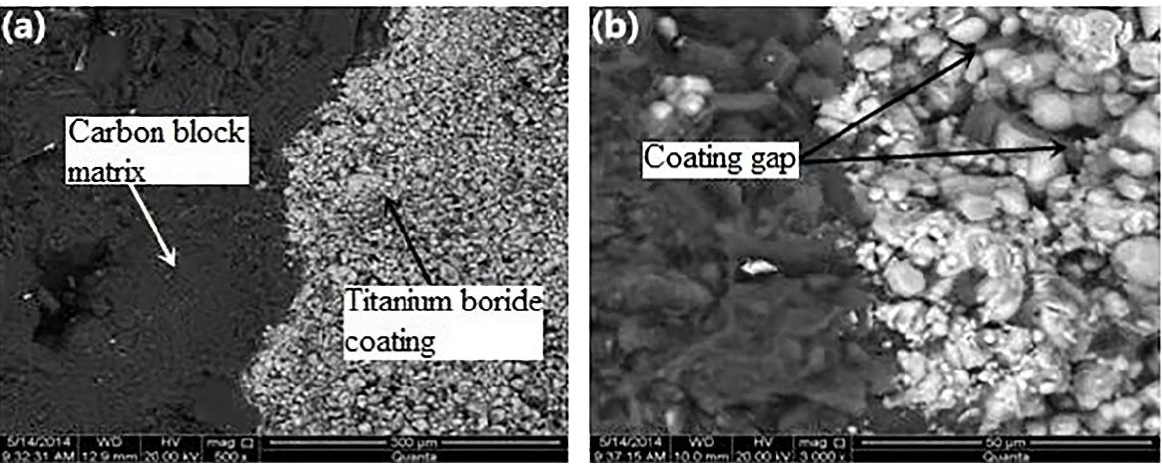
Figure 1. Scanning electron microscopy (SEM) image of TiB 2 coating surface morphology. ( a ) SEM of coating under 600 times, ( b ) SEM of coating under 1000 times.